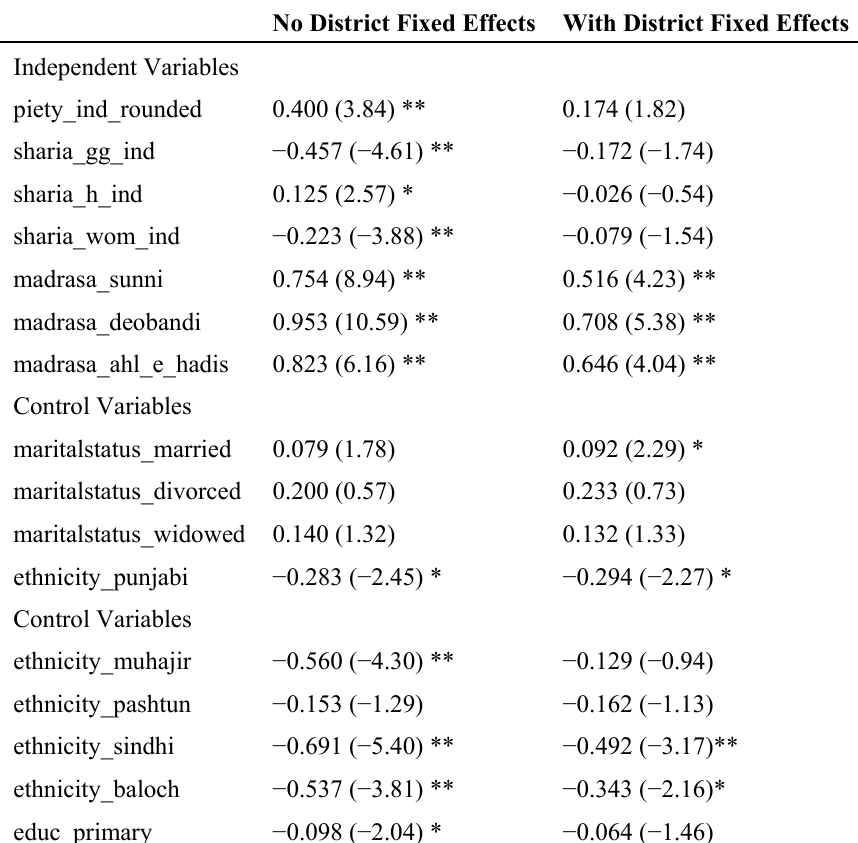
Table 3. Regression Results (How much do you support Sipah-e-Sahaba-e-Pakistan (SSP) and their